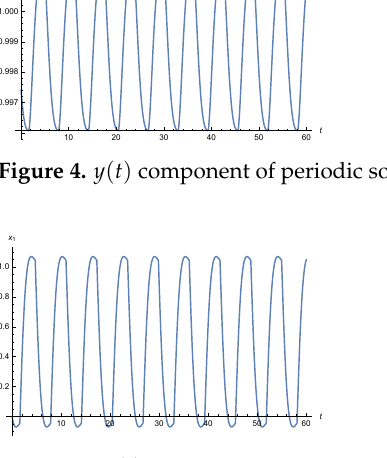
Figure 5. x 1 ( t ) component of periodic solution of (55) with ε = 0.01.